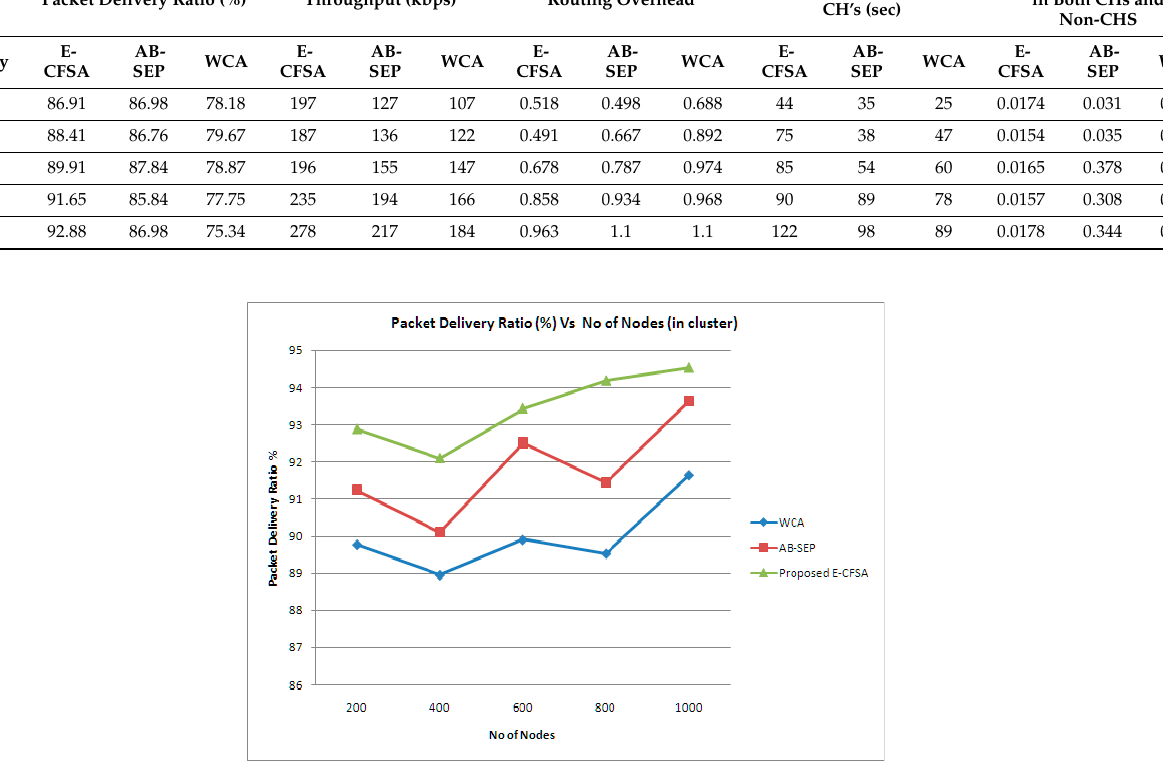
Table 9. Simulation results (Impact of Network Size).